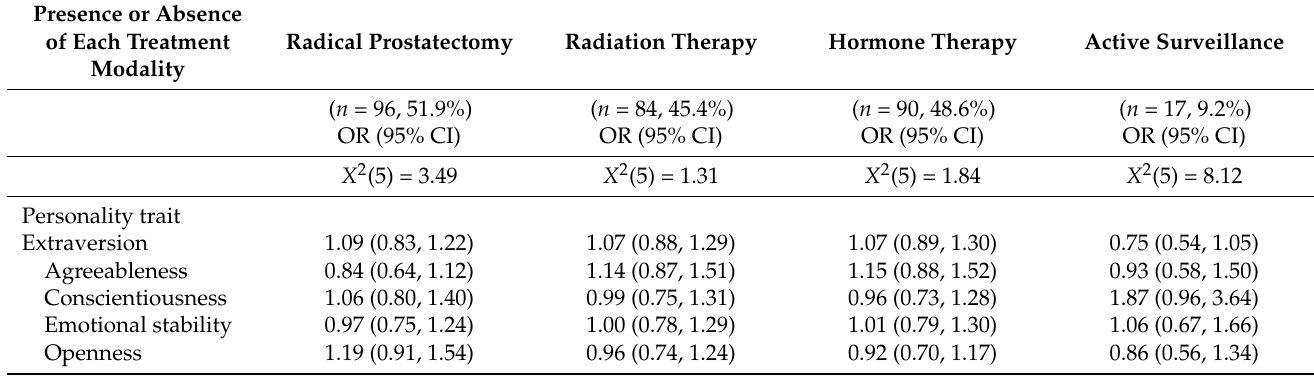
Table 2. Logistic regression analyses assessing the role of personality traits in each treatment modality among men residing in Nova Scotia, aged 50–83, between 2017 and 2020, n = 185.